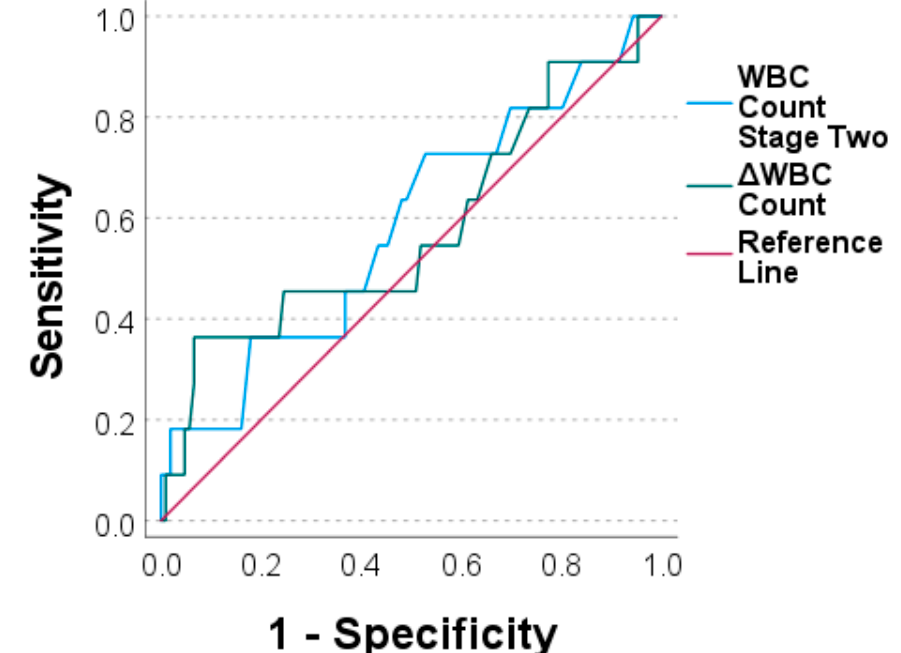
Figure 4. Receiver operating characteristic curves for white blood cell count prior to stage two (“WBC count stage two“) and for Δ WBC count (WBC count stage two minus WBC count stage one). The optimal threshold values were calculated with Youden´s J. The sensitivity and specificity were measured. However, neither the CRP or the WBC count at stage two nor the differences between the stages reached an adequate diagnostic value (Table 2).